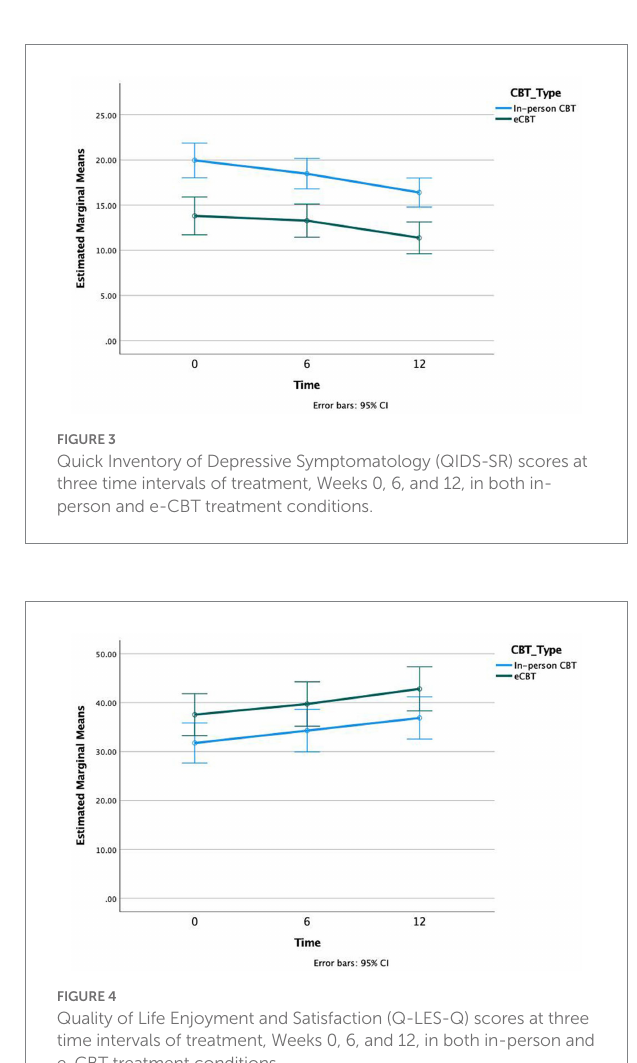
in the in-person group = 0.89 and 0.79 respectively, and in the online group = 0.81 and 0.78, value of p ( t -score) = 0.31(1) and 0.87(0.16) respectively for independent sample t -tests).